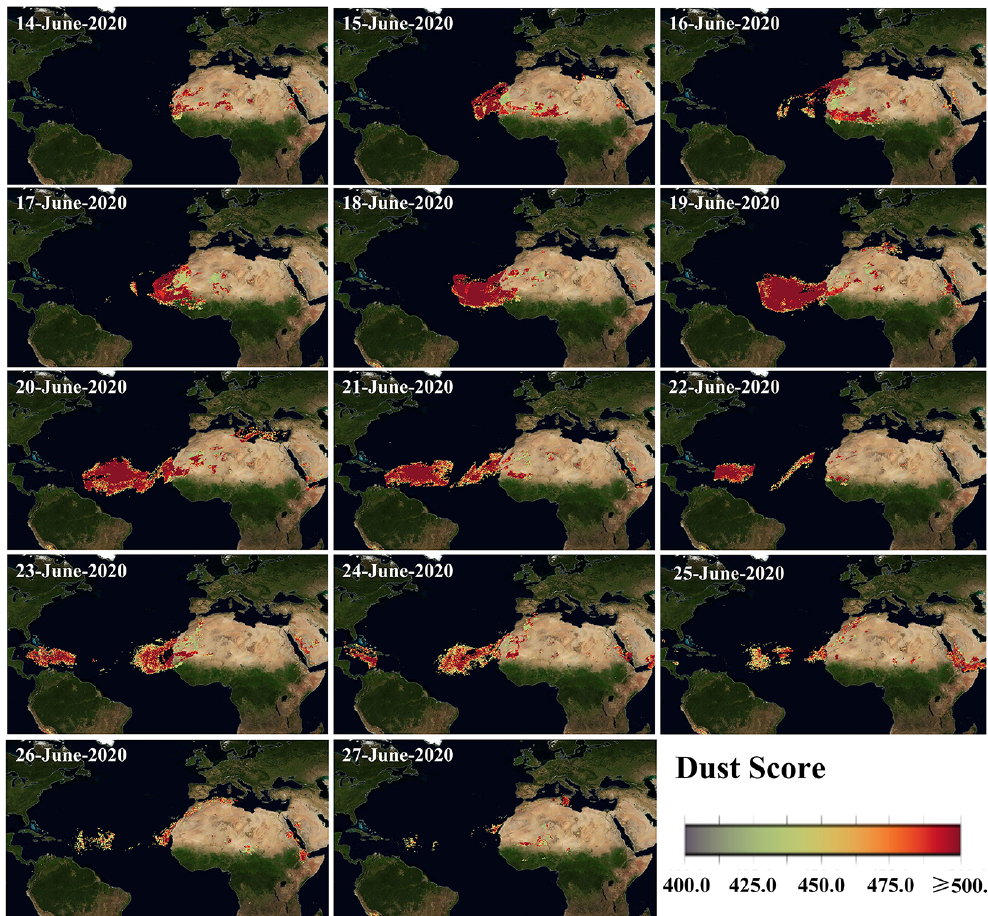
Figure 3. The Dust Score Index provided by AIRS/Aqua at different stages, including emission, transportation, dispersion and deposition (https://airs.jpl.nasa.gov/map/, last access: 10 January